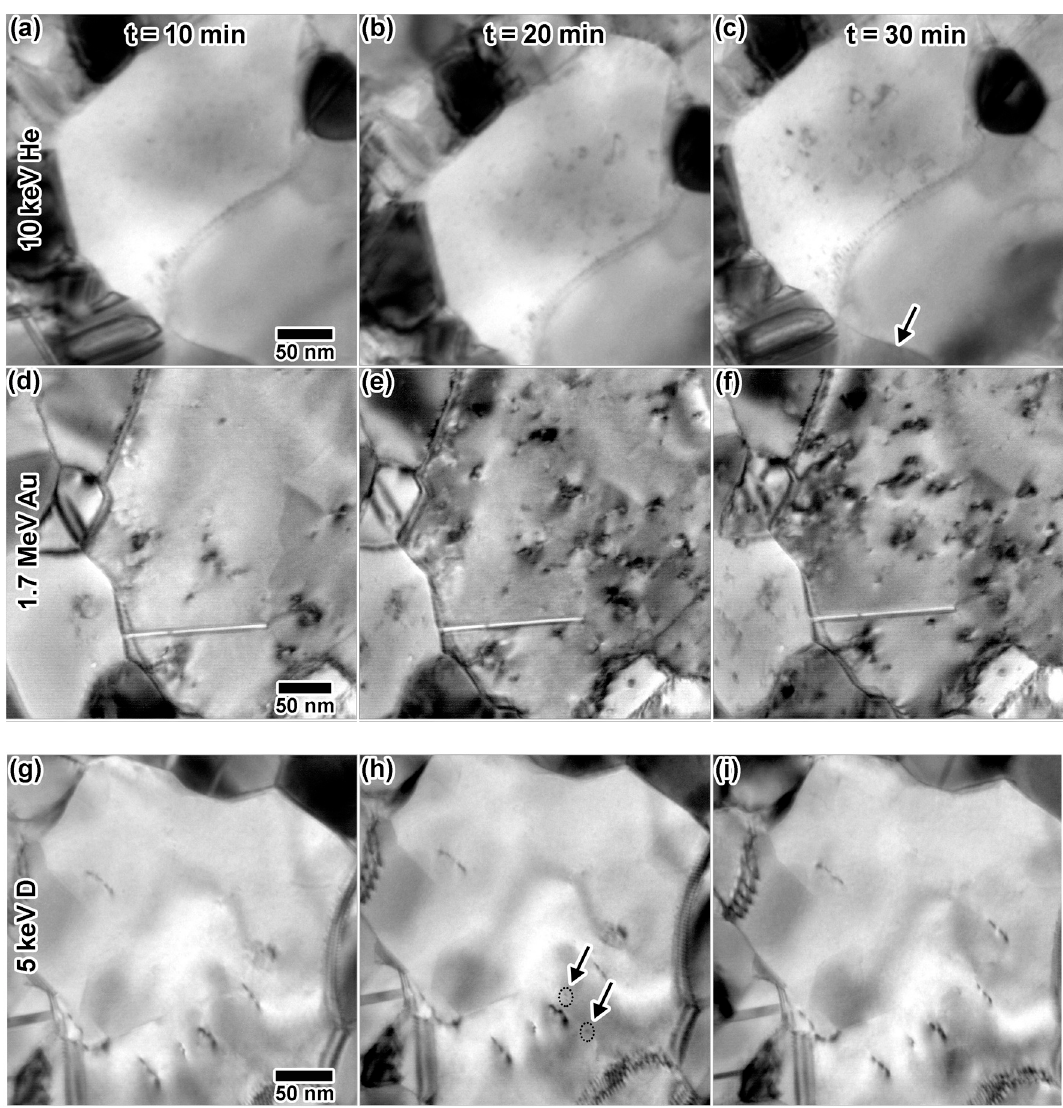
Figure 6. In situ TEM images from single beam irradiations: ( a – c ) 10 keV He; ( d – f ) 1.7 MeV Au and ( g – i ) 5 keV D after 10, 20 and 30 min. The arrow in (c) is pointing toward a grain where bubbles are easily visible (shown zoomed in Figure 7). Dashed circles in (h) highlight defects that were observed and later disappeared. At 30 min, irradiation doses were as follows: (c) 1.54 × 10 17 ions/cm 2 , 9.2 dpa, 31.97 at % He, (f) 7.5 × 10 11 ions/cm 2 , 0.02 dpa, and (i) 1.42 × 10 17 ions/cm 2 , 1.8 dpa, 30.94 at % D. All TEM images were taken at the same magnification.